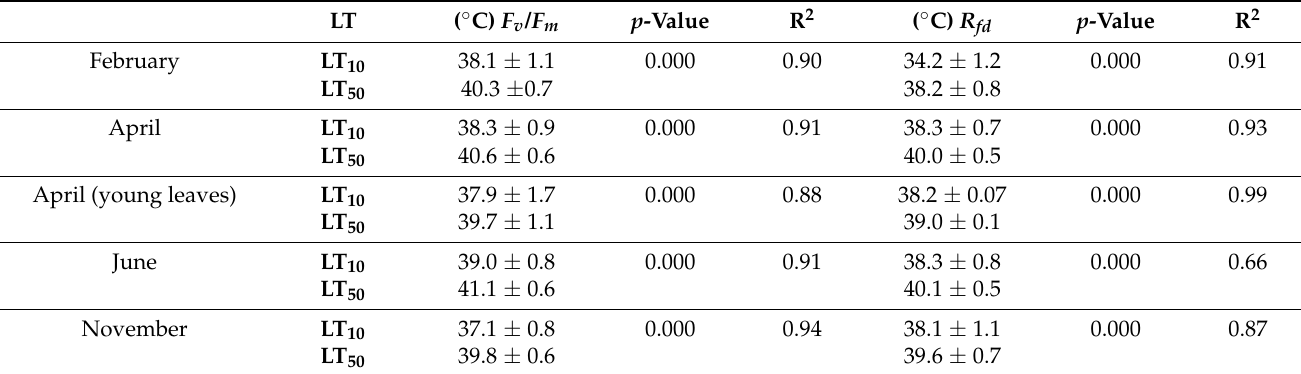
Table 2. LT 10 and LT 50 estimated from high temperature treatments from the maximal photochemical efficiency of PSII ( F v /F m ) and the R fd data shown in Figure 3 and obtained from the regression model. Values are mean ± confidence interval. Significance ( p -value) and fit (R 2 ) to the regression are